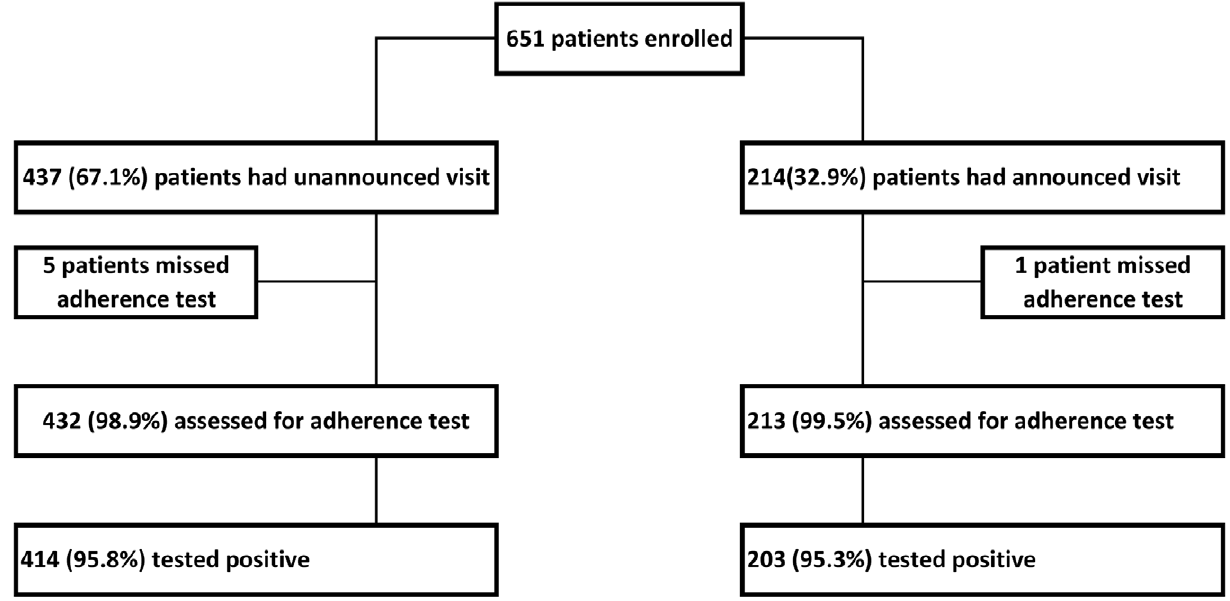
Figure 1. Adherence assessments.